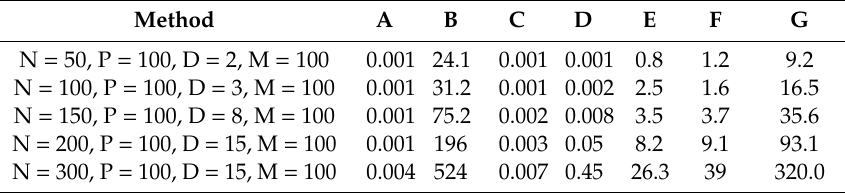
Table 13. Execution time comparison of the TSP algorithms (in sec).